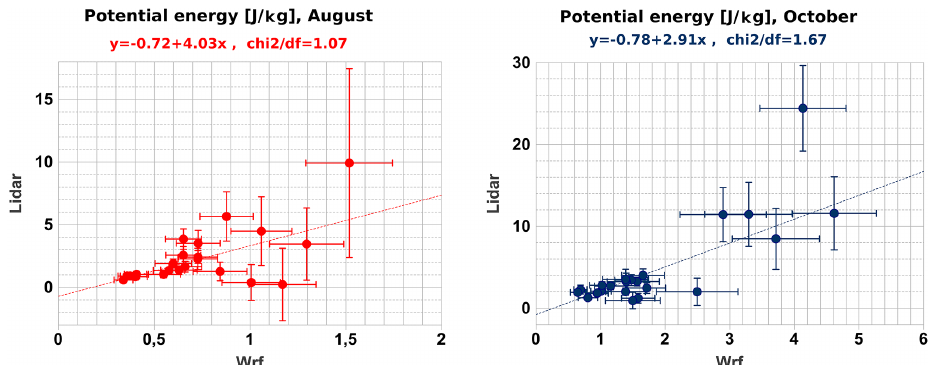
Figure 12. Scatterplot between real case WRF simulation ( x axis) and lidar data ( y axis) of potential energy per unit mass (Jkg − 1 ) for August (left) and October (right) 2012. Dotted line represents the best line considering errors on both x and y . The equation of best-line fit is reported, together with the reduced chi-square value (i.e. divided by the degrees of freedom, df). Error bars as in Fig.